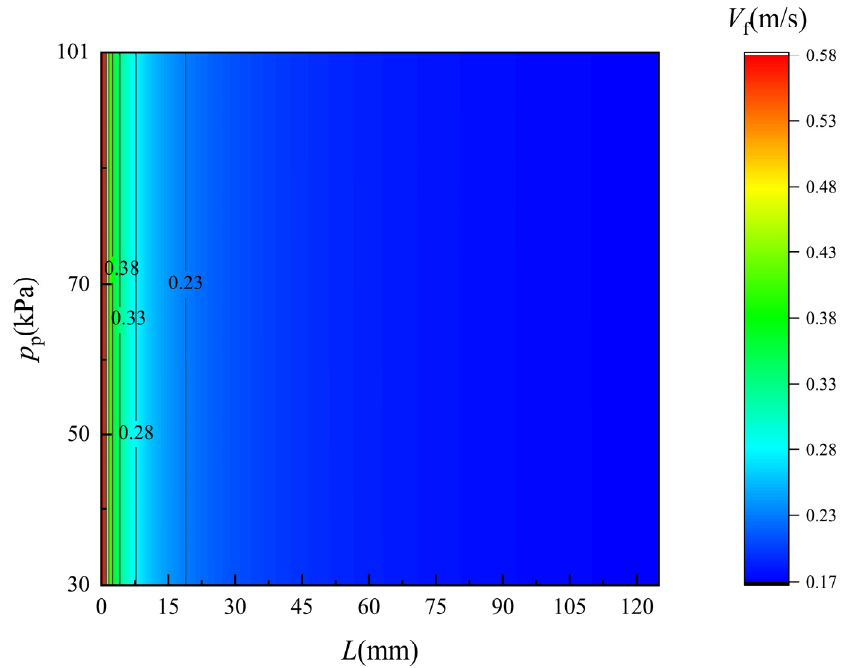
Figure 8. Velocity distribution of the flow along the feed side of the membrane surface. T f = 318 K.